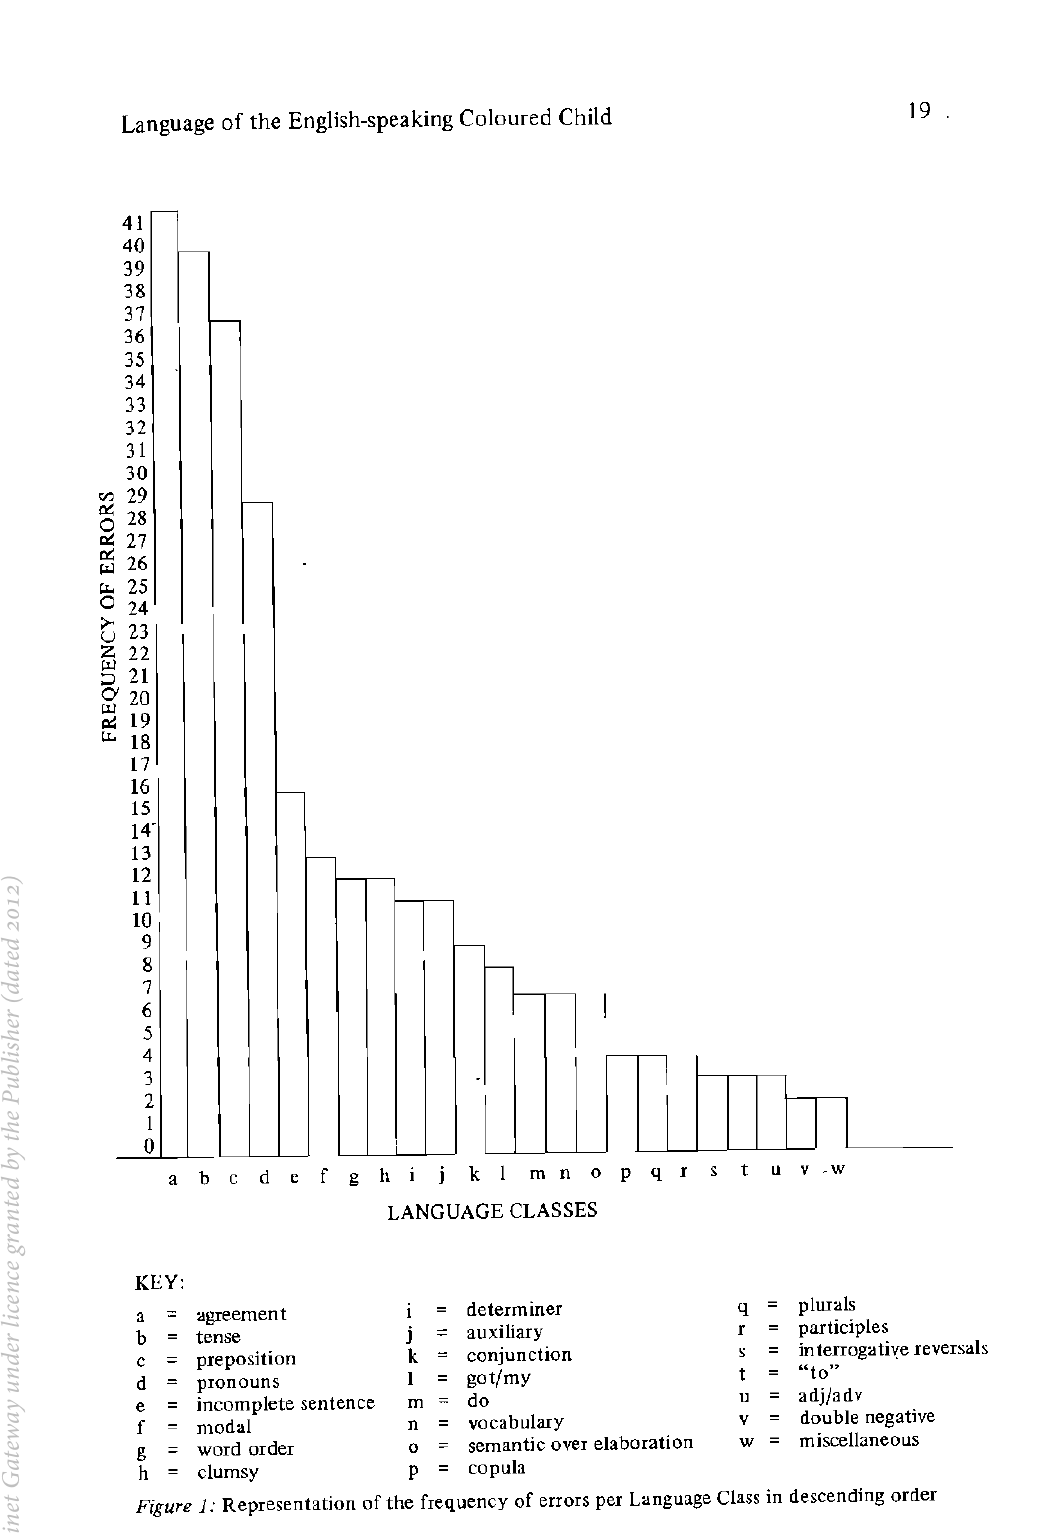
Figure 1: Representation of the frequency of errors per Language Class in descending order Tydskrif van die Suid-Afrikaanse Vereniging vir Spraak- en